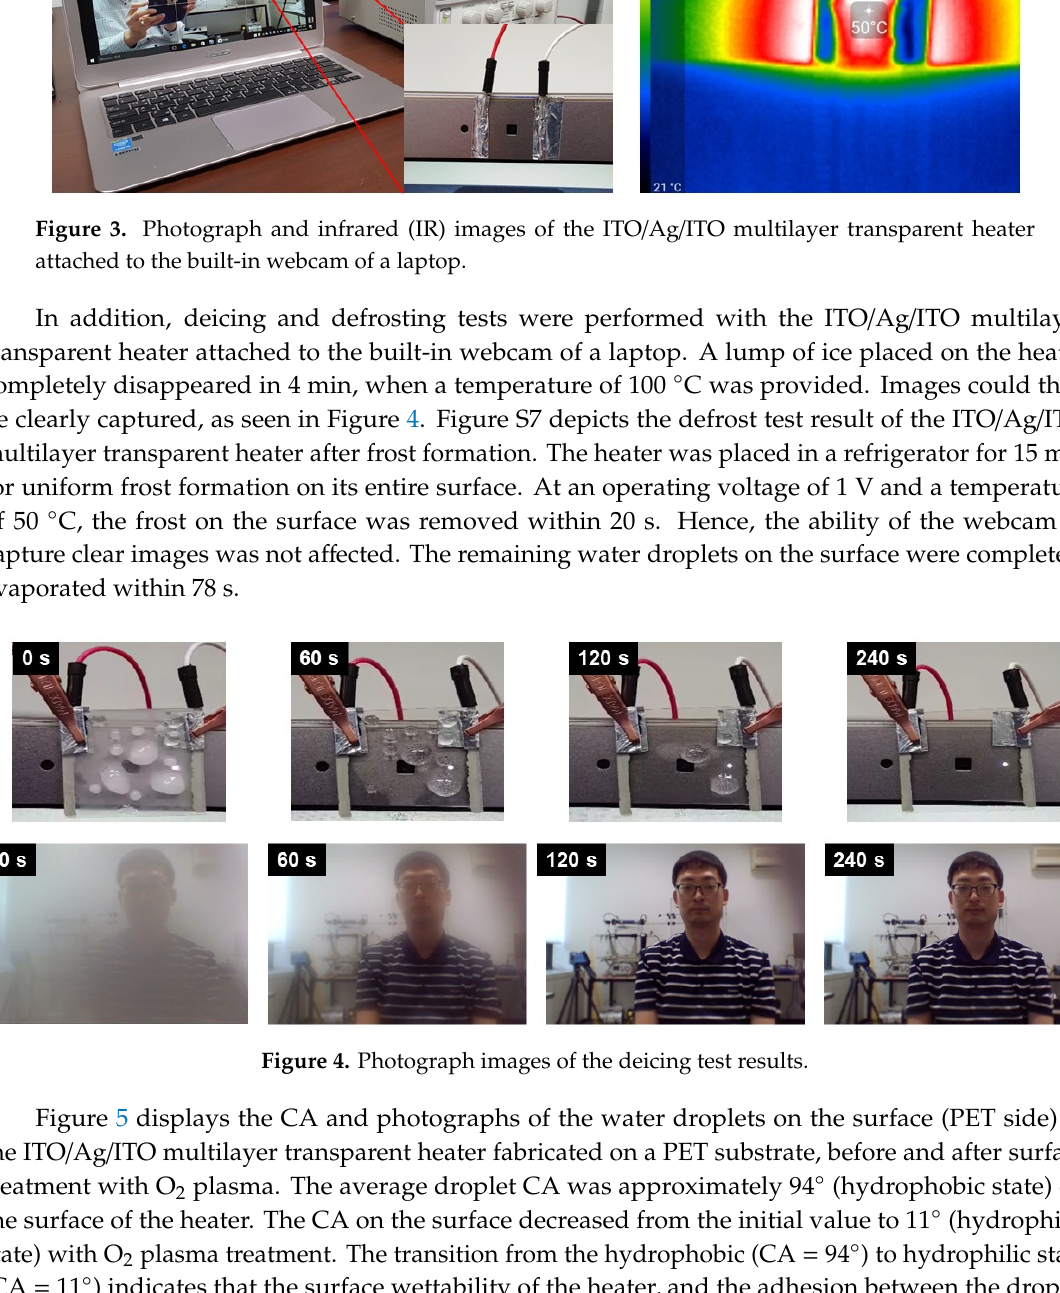
Figure 4. Photograph images of the deicing test results.